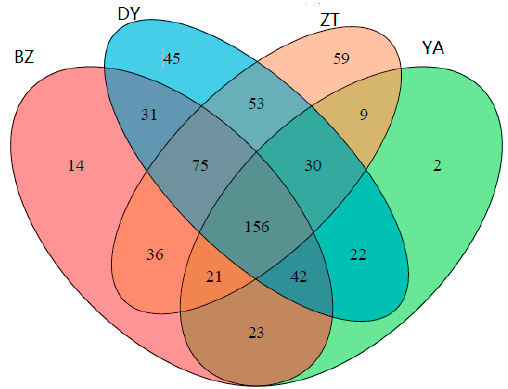
Figure 7. The fungal OTU cluster Venn diagram.